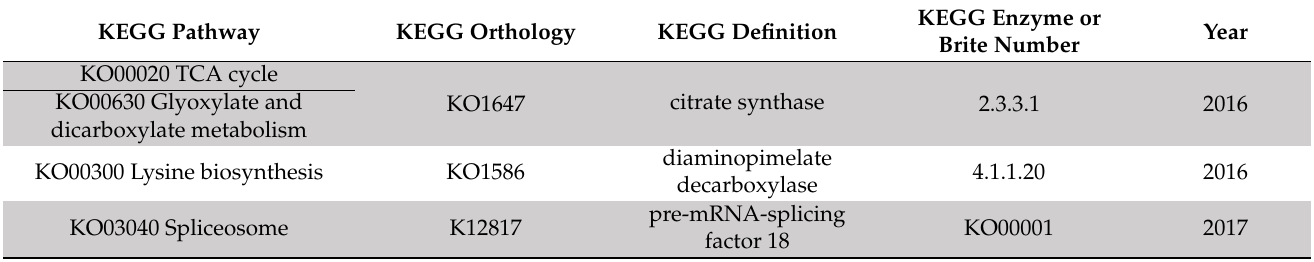
Table 5. KEGG terms of candidate genes both in 2016 and